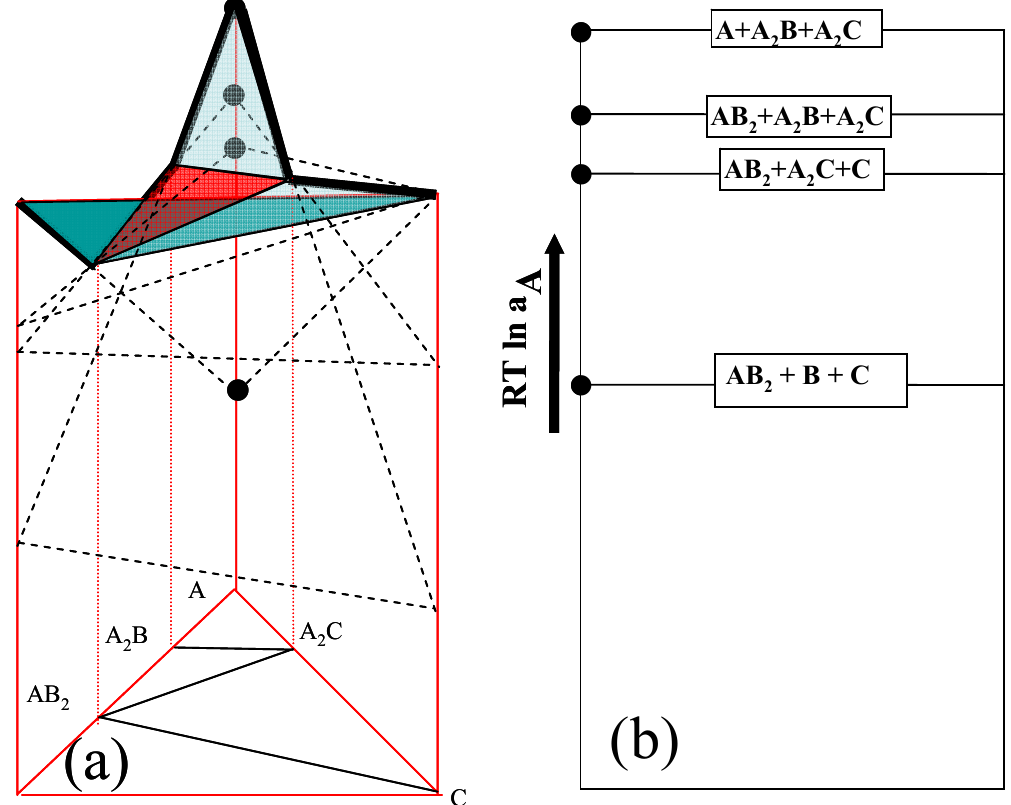
Figure 1. Schematic diagram of (a) three-dimensional tangential plane of free energy and (b) two- dimensional chemical potential diagram